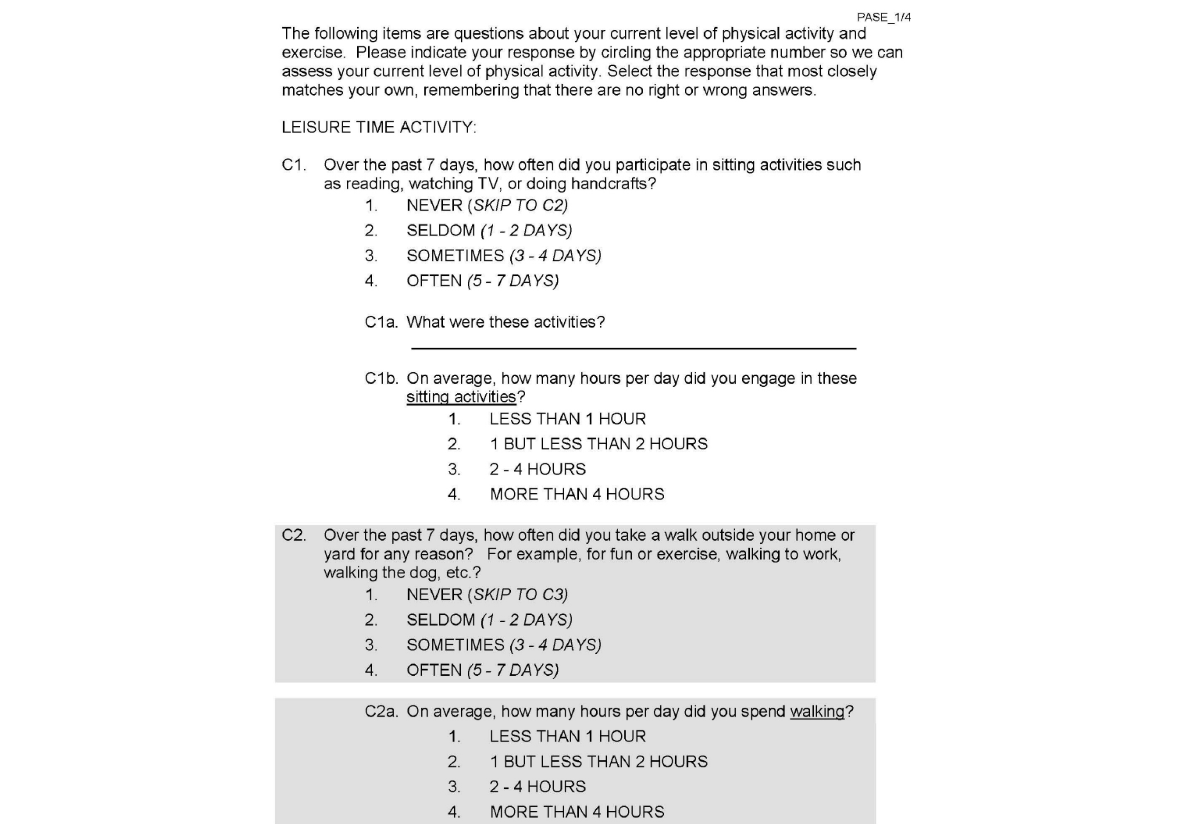
Figure 1. Sample printed